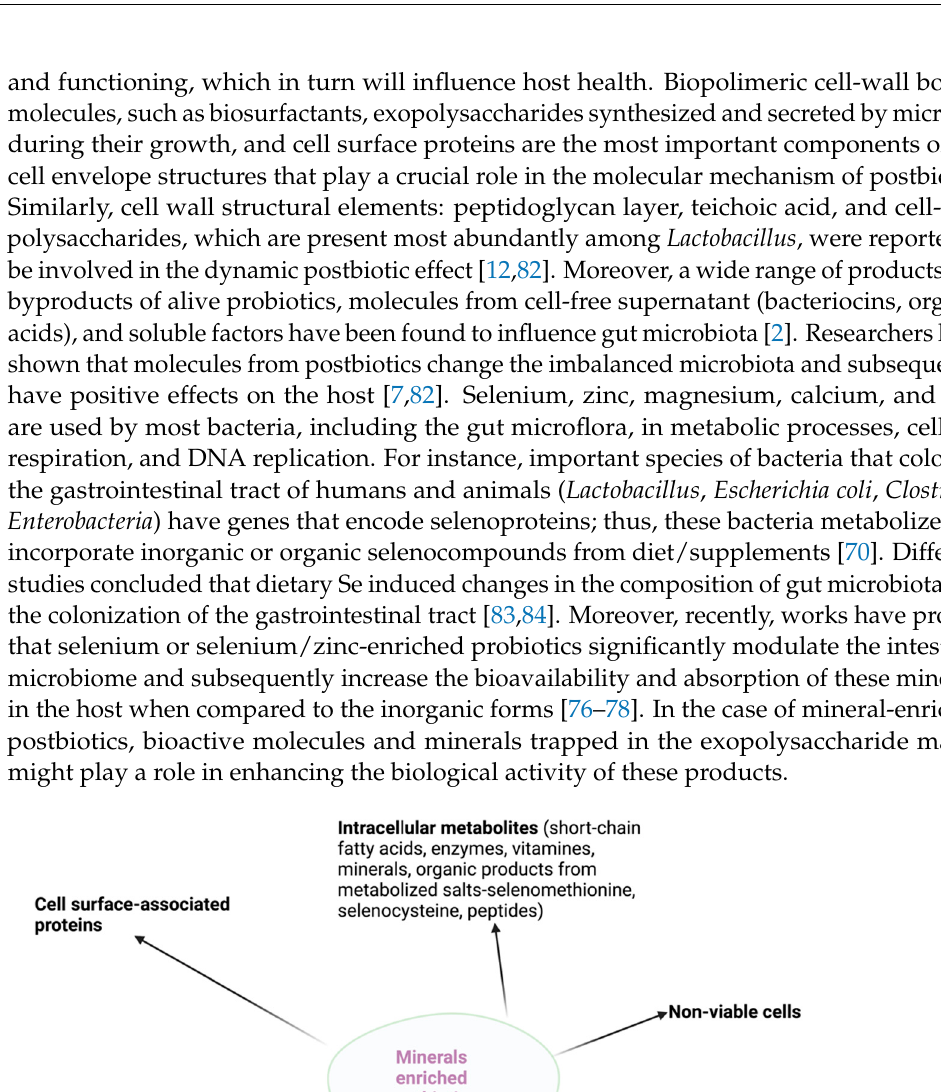
Figure 2. Mineral-enriched postbiotic advantages and beneficial health effects. Some postbiotics display antimicrobial and anti-adhesion activities by sealing the in- testinal barrier, changing the local environment, or competing with pathogens for binding